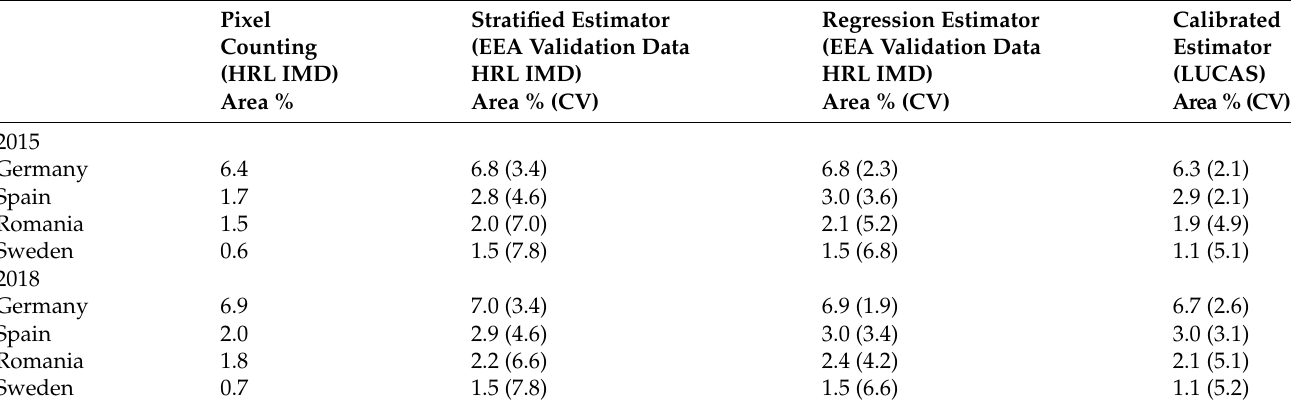
Table 5. Impervious area proportion from pixel counting and estimated using stratified estimator, regression estimator, and estimated from LUCAS survey data a